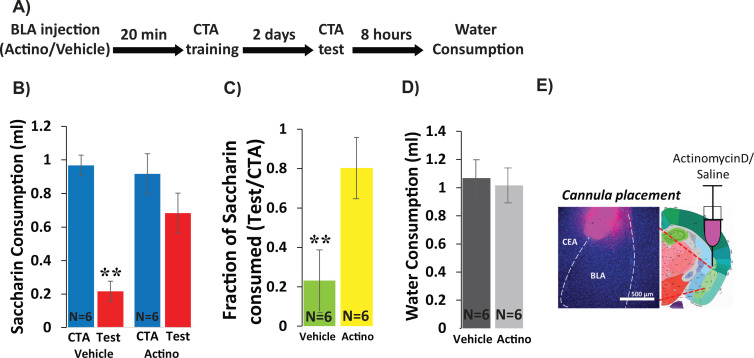
Inhibiting BLA transcription impairs CTA Learning.(A) Protocol for injection (1 µl per hemisphere) of Actinomycin-D (50 ng) or vehicle (PBS with 0.02% DMSO). (B) Actinomycin D injection prior to CTA training impairs learning, expressed as a reduction in saccharin consumption between CTA and test sessions. Two-way mixed ANOVA revealed a significant effect of treatment and a significant interaction between training and treatment (treatment: F(1,10) = 9.99, p=0.010; training: F(1,10) = 4.62, p=0.057; interaction: F(1,10) = 5.237, p=0.045). Post hoc analysis (Bonferroni corrected) revealed significant reductions (p=0.001) of saccharin consumption (training vs. test) for vehicle treated, but not for actinomycin-D treated mice (p=0.94), and significant differences between the treatment groups during the test (p=7.1×10−3) but not during the training session (p=0.56). (C) Fraction of saccharin consumed (Test/CTA) was significantly higher (t(10)=-3.4; p=0.007) following Actinomycin D treatment than vehicle, consistent with weaker memory. (D) Treatments did not differ in water consumption measured 8 hr later (t(10)=0.28; p=0.79) suggesting this does not account for differences in consumption during the test. **p<0.01. (E) Guide cannula was coated with fluorescent dye to assess placement (Left) relative to desired location in anterior BLA (Right; bregma −1.4 mm; Allen brain atlas). Note that the injection cannula extended 0.5 mm further into the BLA. See also Figure 1—source datas 1 and 2 and Figure 1—figure supplement 1.Figure 1—source data 1.Saccharin consumption (ml) during CTA training and test.This data relates to Figure 1 panel B.Figure 1—source data 2.Fraction of saccharin consumed (Test/Training).This data relates to Figure 1 panel C.